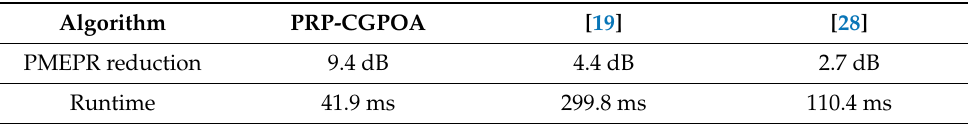
Table 2. PMEPR reduction and runtime comparison of PRP-CGPOA, Refs. [19,28] to achieve 3 dB PMEPR.